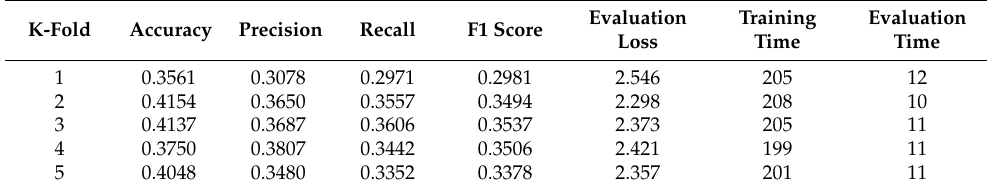
Table 9. DistilBERT—Brexit Blog Corpus dataset.